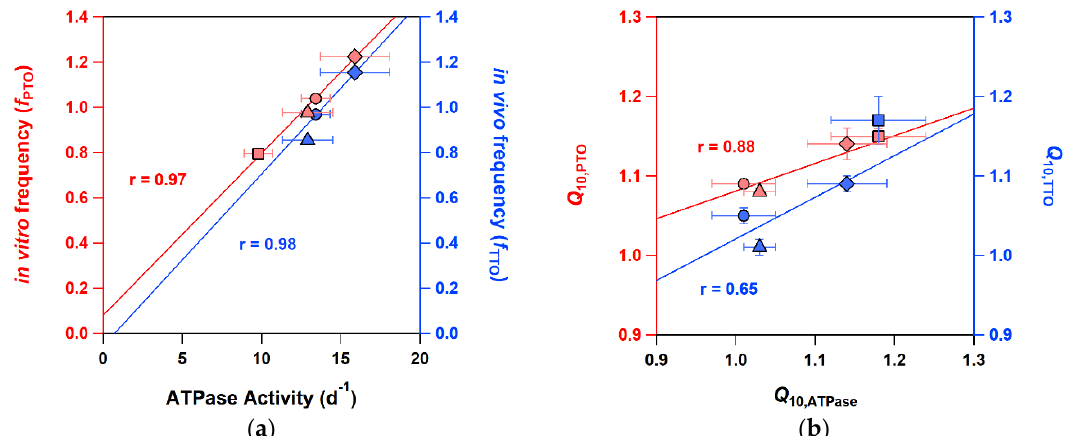
Figure 5. Cross-correlational plots of ( a ) in vivo frequency of bioluminescence rhythms ( f TTO ), in vitro frequency of KaiC phosphorylation cycles ( f PTO ), and in vitro ATPase activity of KaiC alone at 30 °C, and of ( b ) the Q 10 values for bioluminescence rhythms ( Q 10,TTO , 25~29 °C), KaiC phosphorylation cycles ( Q 10,PTO , 25~35 °C), and in vitro ATPase activity of KaiC alone ( Q 10,ATPase , 25~35 °C). Filled circles, triangles, squares, and diamonds correspond to KaiC-WT, KaiC-P37A, KaiC-T228A, and KaiC-C306A, respectively. Red and blue markers correspond to in vitro (PTO) and in vivo (TTO) data, respectively. Thick lines represent linear fits to the data with correlation coefficients (r).